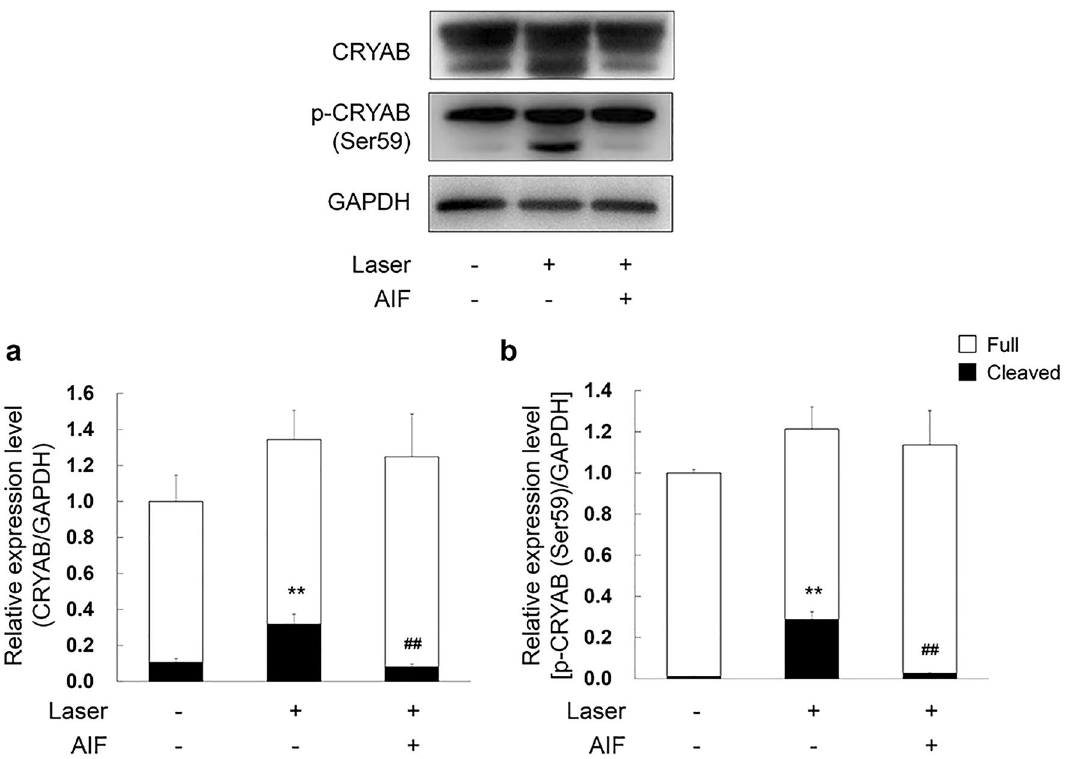
Figure 7. Inhibitory effects of alpinumisoflavone (AIF) on crystallin alpha B (CRYAB) and phosphorylated- CRYAB (p-CRYAB) expression in laser-induced choroidal neovascularisation (CNV) model. Intravitreal injection of 25 mg/mL AIF was administered immediately after laser exposure. The tissue lysates from three animals were pooled as one sample and equal amounts of protein were analysed for determining expression of the indicated proteins. The cleaved form of ( a ) CRYAB and ( b ) p-CRYAB reduced by 25 mg/mL AIF treatment in the laser-induced CNV model. Experiments were performed in triplicate and data were analysed using one-way ANOVA followed by the Holm-Šídák post-hoc t-test (** p < 0.01 vs. non-laser exposed group, ## p < 0.01 vs. only Laser exposed group). The results are expressed as mean ± S.E. (n = 3). Each error bars represent standard deviation from triplicate reading of three pooled samples. Uncropped blot images are presented in supplementary information (Supplementary Fig. 4).